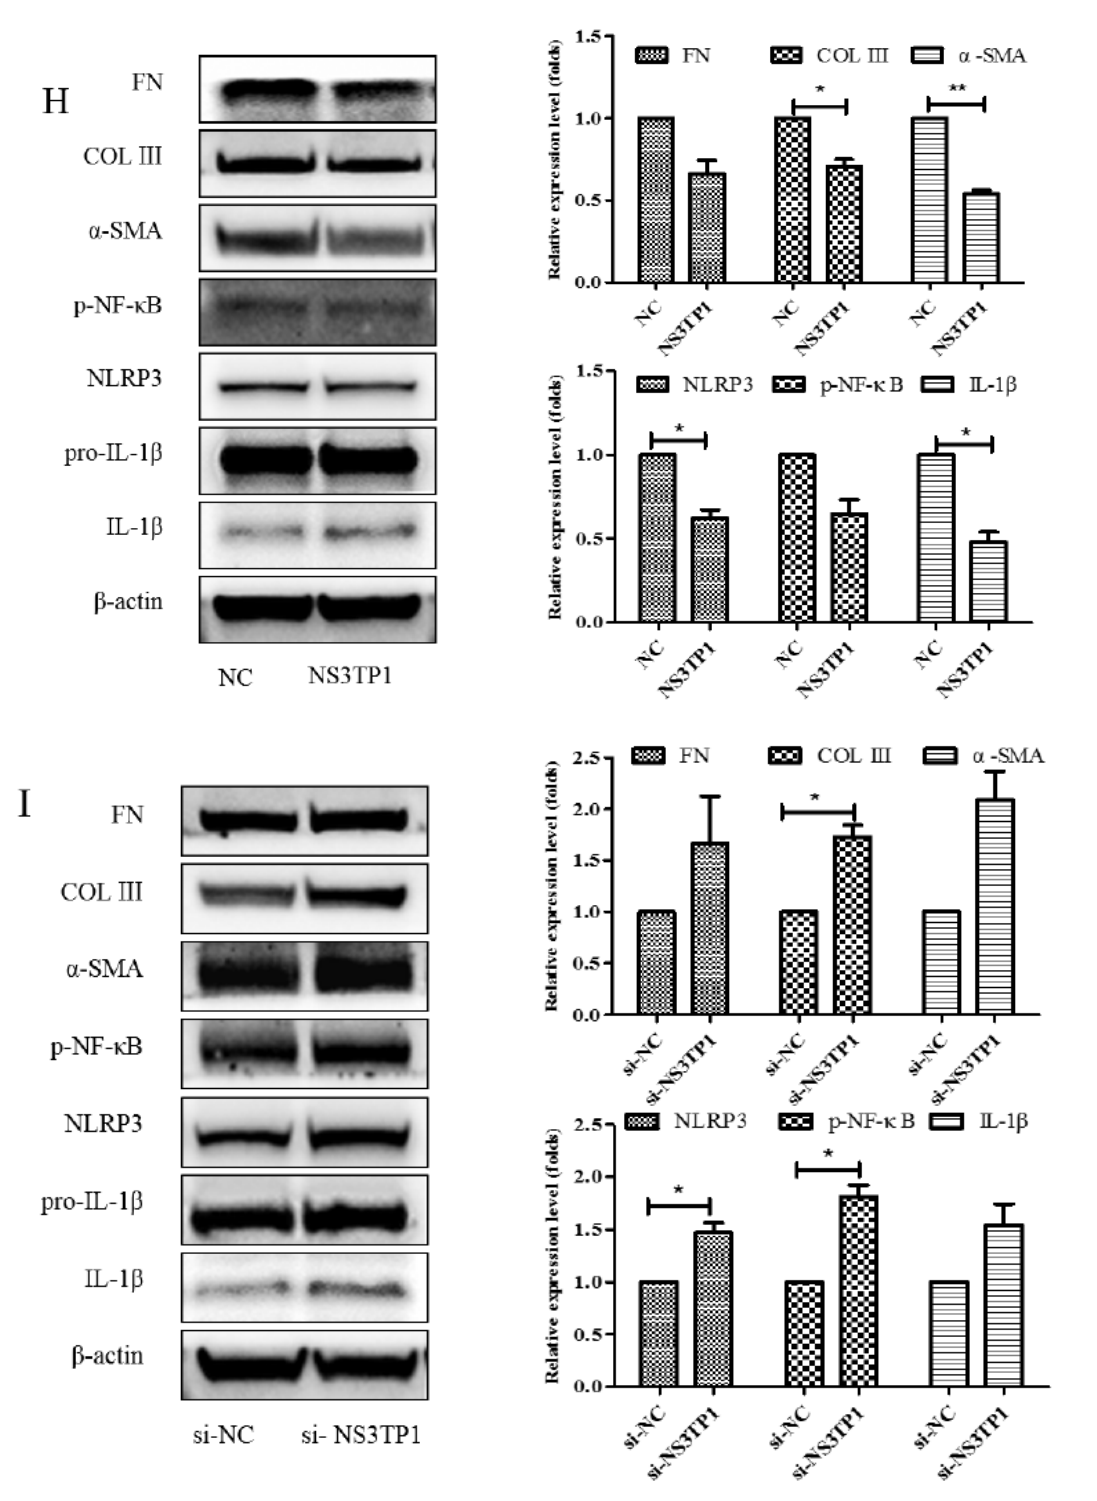
Figure 6. Asp inhibited liver fibrosis by upregulating NS3TP1 expression and then inhibiting the NF- κ B/NLRP3 signaling pathway. ( A – E ) The expression of NS3TP1 was detected by real-time PCR. ( F – I ) LX-2 cells were transfected transiently with pcDNA 3.1/myc-His( − )-NS3TP1 plasmid or siRNA-NS3TP1 for 48 h. Real-time PCR ( F , G ) and Western blot ( H , I ) analysis of the mRNA and protein levels of genes about NF- κ B signaling pathways and liver fibrosis in LX-2 cells, respectively, which were quantified using the ImageJ software, n = 3. The results shown are mean ± standard error. * p < 0.05, ** p < 0.01, *** p <